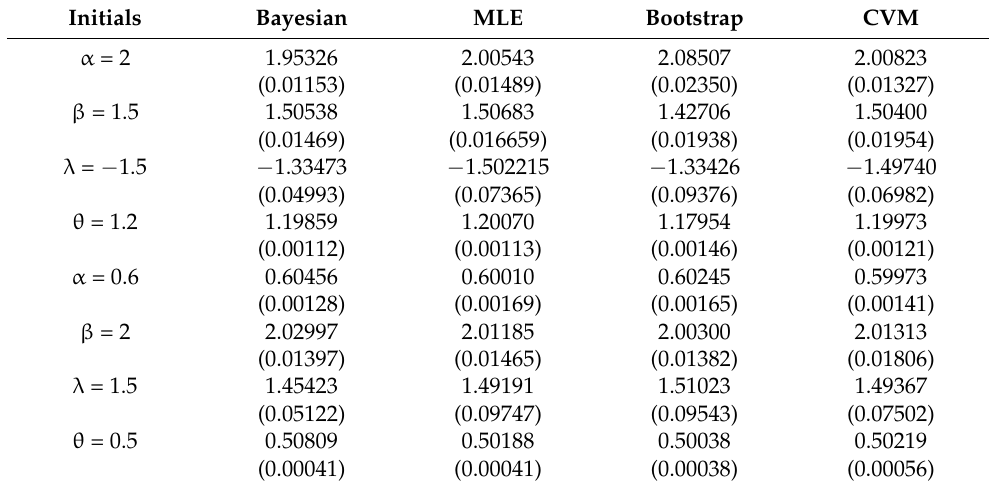
Table 5. The results of the AVs and their corresponding MSEs (in parentheses) for n = 200.